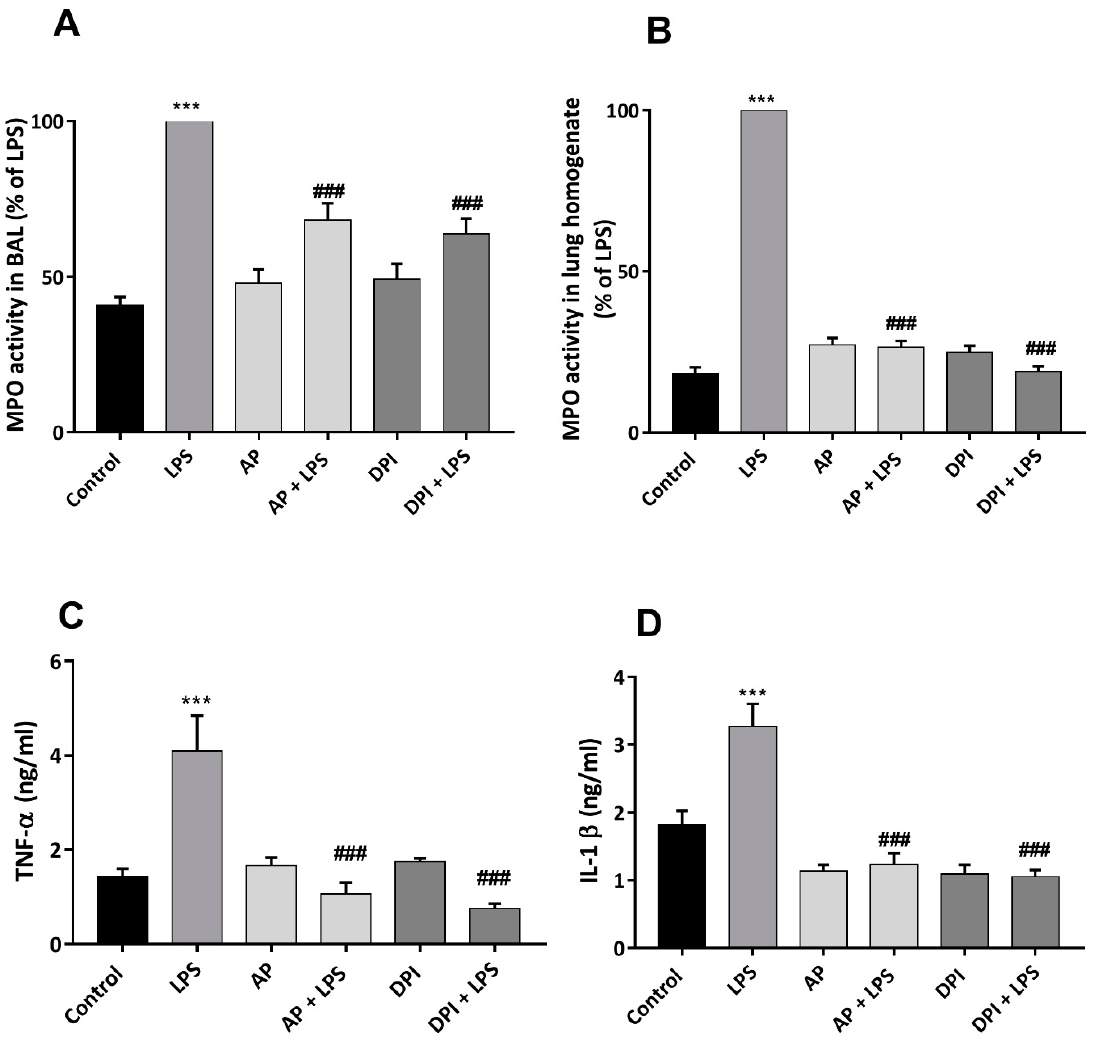
Figure 6. Effect of apocynin and DPI on the inflammatory markers MPO activity in BAL ( A ), lung homogenate ( B ), TNF- α ( C ) and IL-1 β ( D ) during the induction of acute lung inflammation by LPS. Data are displayed as mean ± SEM and represent at least five ( n = 5) independent experiments. *** p < 0.001 significant differences as compared to the control group ### p < 0.001 significant differences as compared to the LPS group.